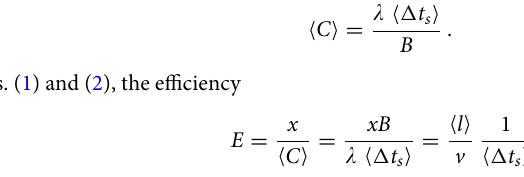
thus also quantifies the service efficiency from the customer perspective 25 .